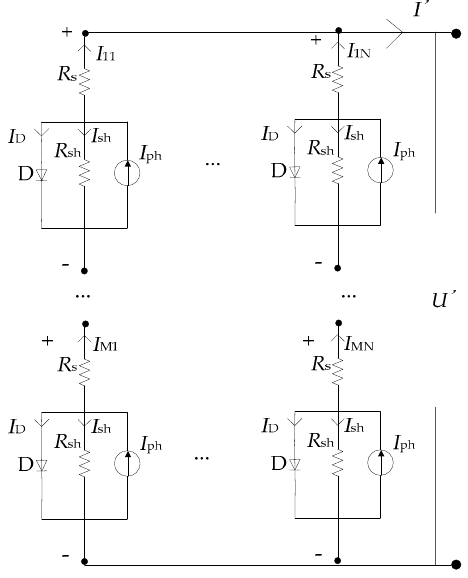
Figure 2. The equivalent circuit model of photovoltaic array.